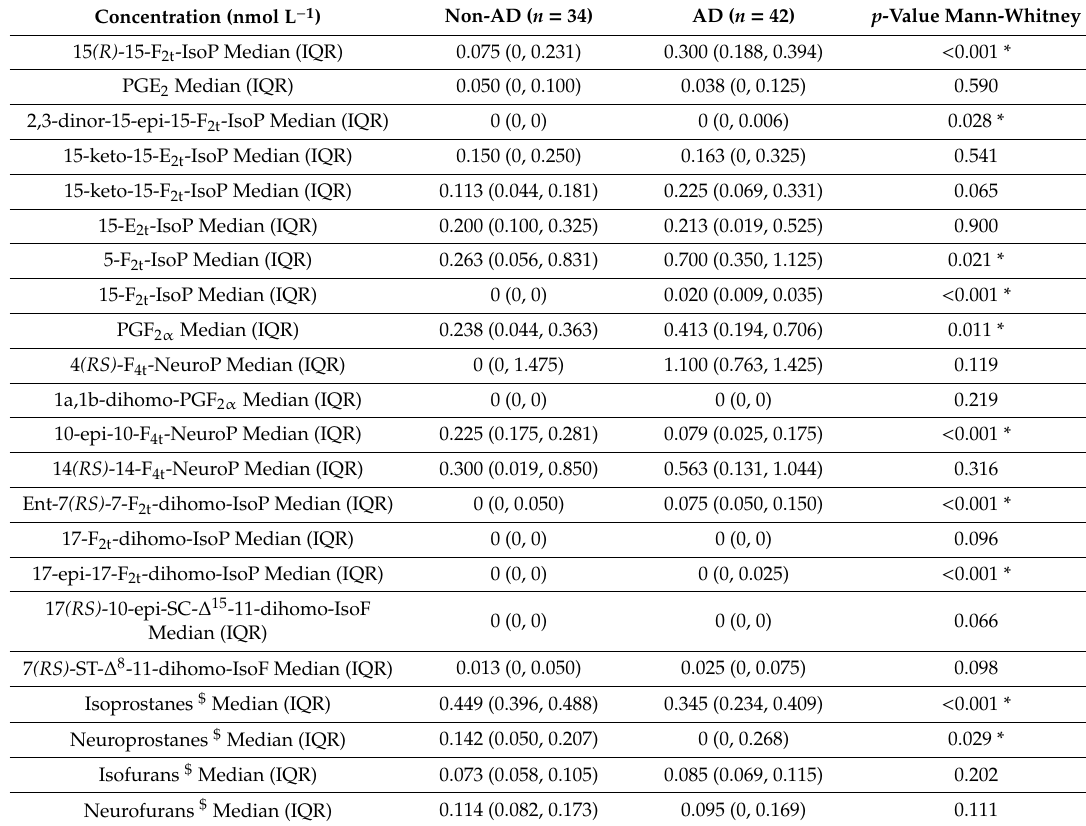
Table 3. Concentrations of lipid peroxidation biomarkers in plasma